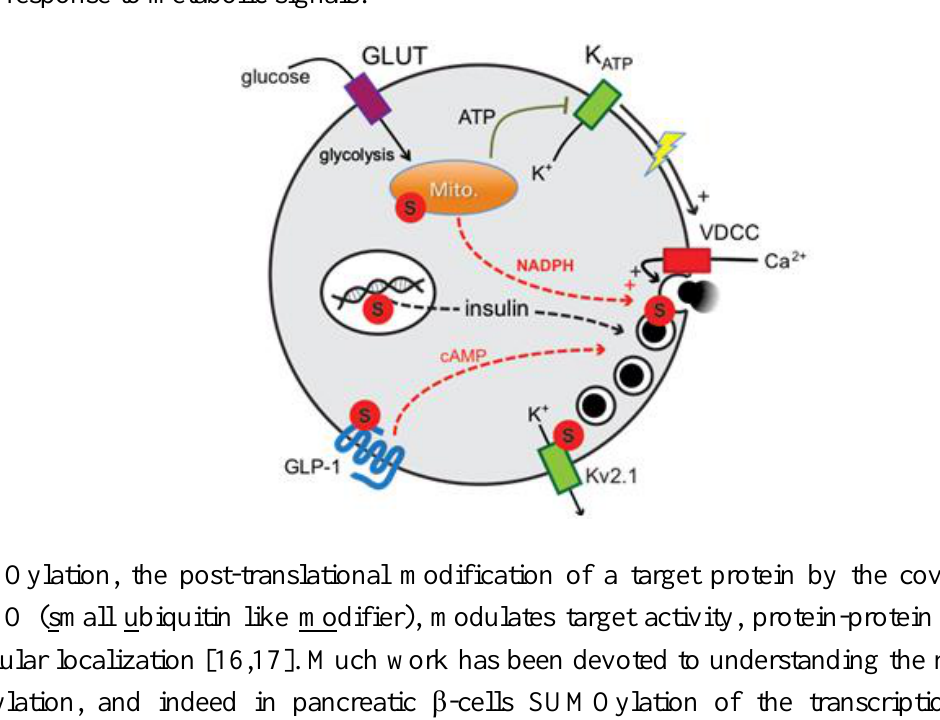
Figure 1. Potential sites of regulation by SUMOylation in the mechanism of glucose-stimulated insulin secretion from pancreatic β-cells. The general mechanism regulating insulin secretion through triggering and amplifying pathways is shown. SUMOylation (S) may control insulin gene transcription, mitochondrial (Mito.) function, GLP-1 receptor signaling/localization, Kv2.1 channel function and downstream exocytosis in response to metabolic